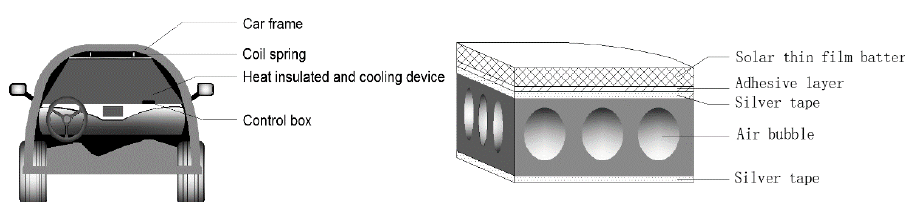
Figure 1. The intermediate sectional view of the mounting position of the device